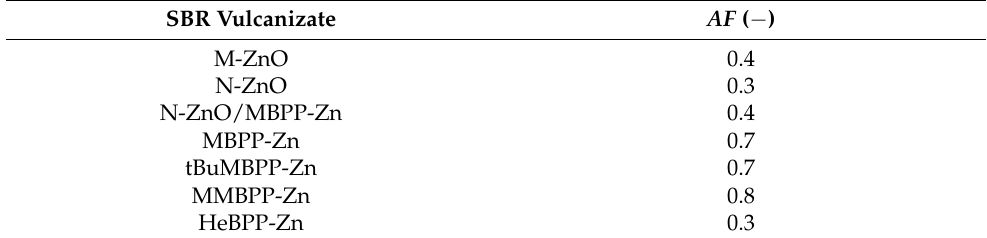
Table 7. Thermo-oxidative aging coefficient ( AF ) of SBR vulcanizates containing ZnO and zinc complexes with 1,3-diketones as activators (SD: AF ±